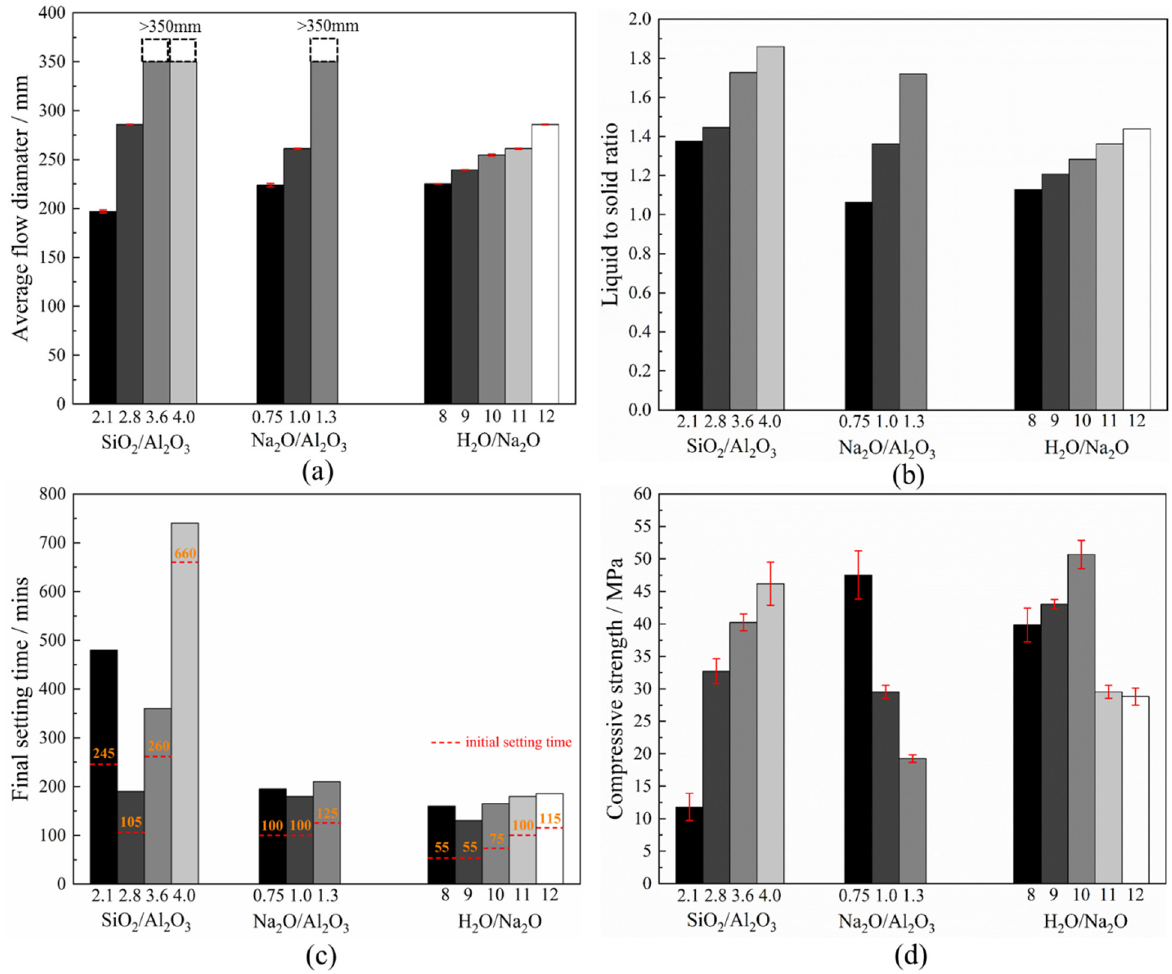
Figure 10. ( a ) Workability, ( b ) liquid-to-solid ratio, ( c ) setting time and ( d ) compressive strength of geopolymers made with varying compositional ratios (>350 mm indicates that the diameter of mixture is more than 350 mm after 25 blows on flow table).